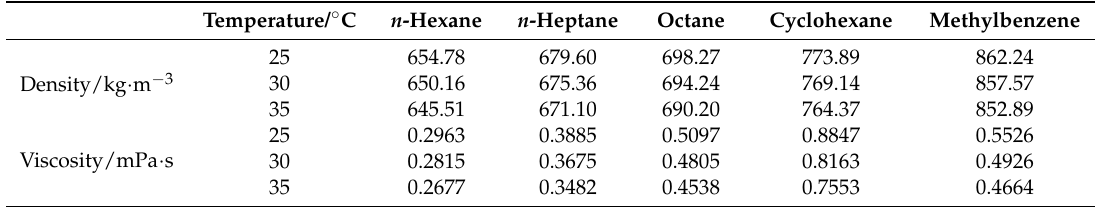
Table 1. Reference density and viscosity values of different fluids.